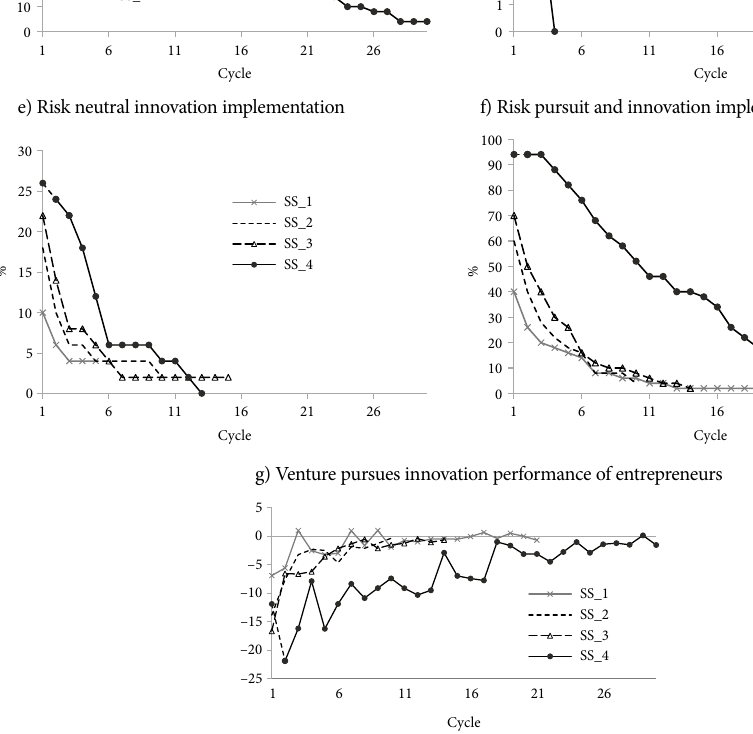
Figure 6. Evolution of entrepreneur innovation behavior with different risk preferences in the structural social capital